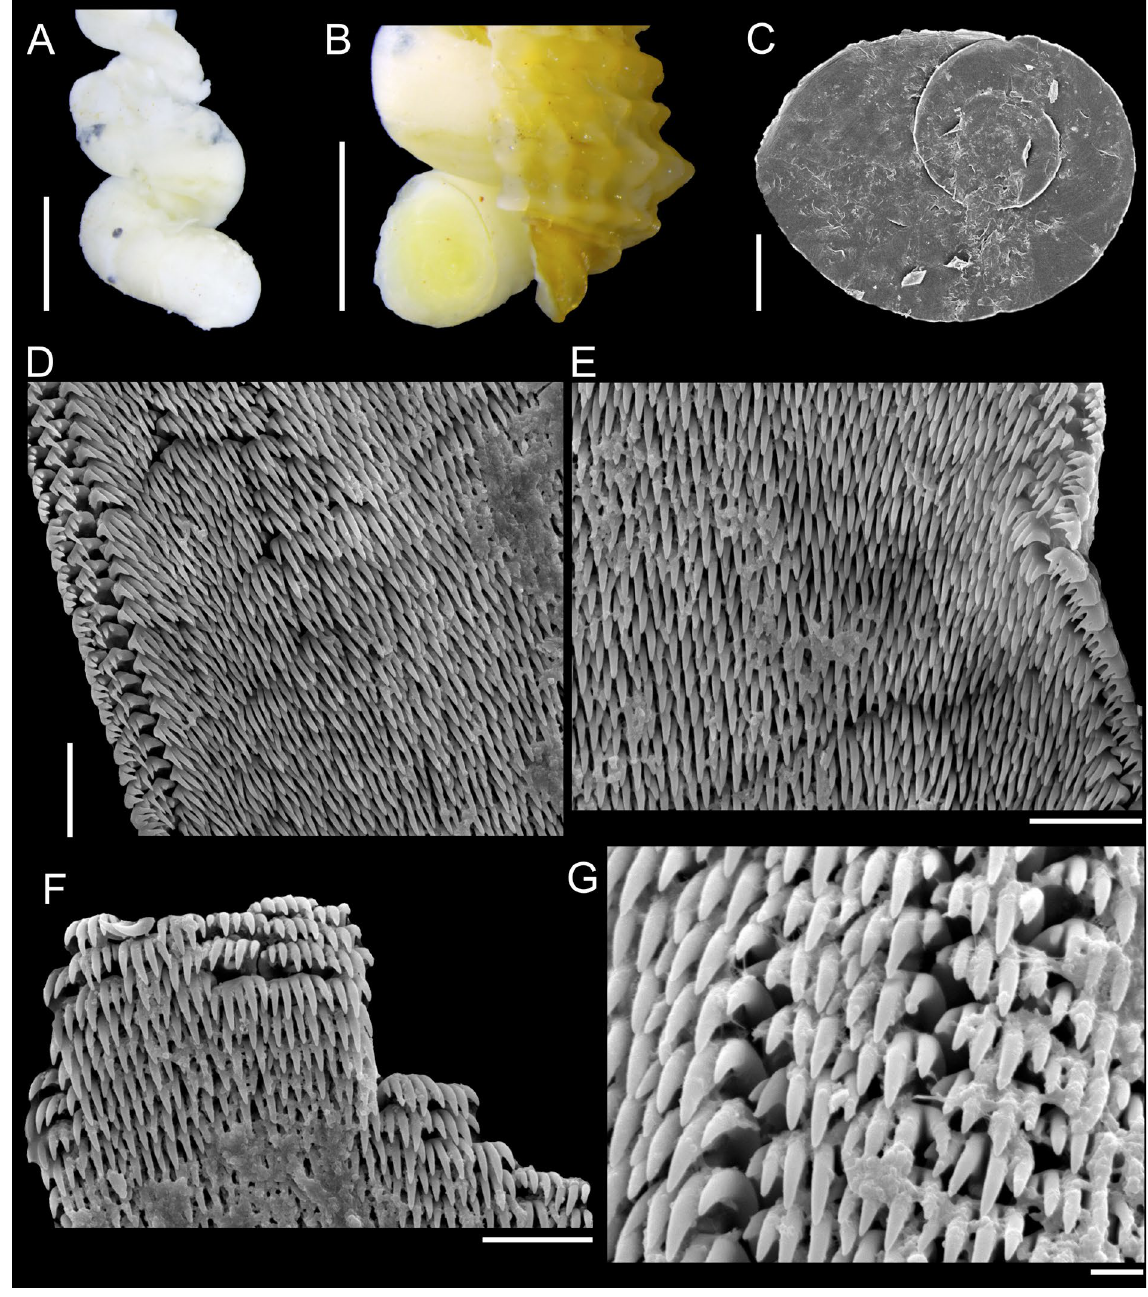
Fig. 30. “ Inella ” harryleei Rolán & Fernández-Garcés, 2008. A–G . FLMNH 450495. A–B . External morphology. C . Operculum. D–G . Radula. Scale bars: A–B = 1 mm; C = 200 µm; D–F = 10 µm; G = 2